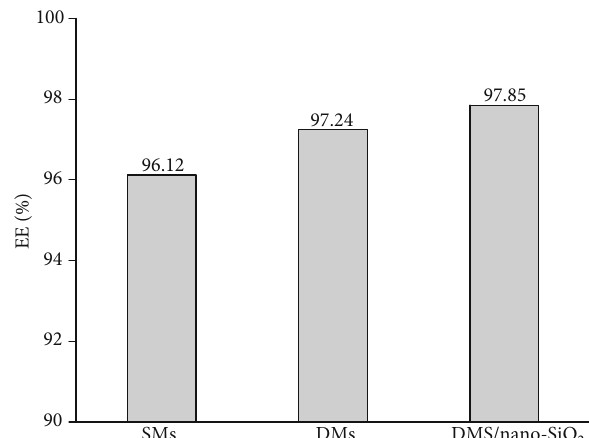
Figure 1: Encapsulation e ffi ciency of SMs, DMs and DMs/nano- SiO . 2